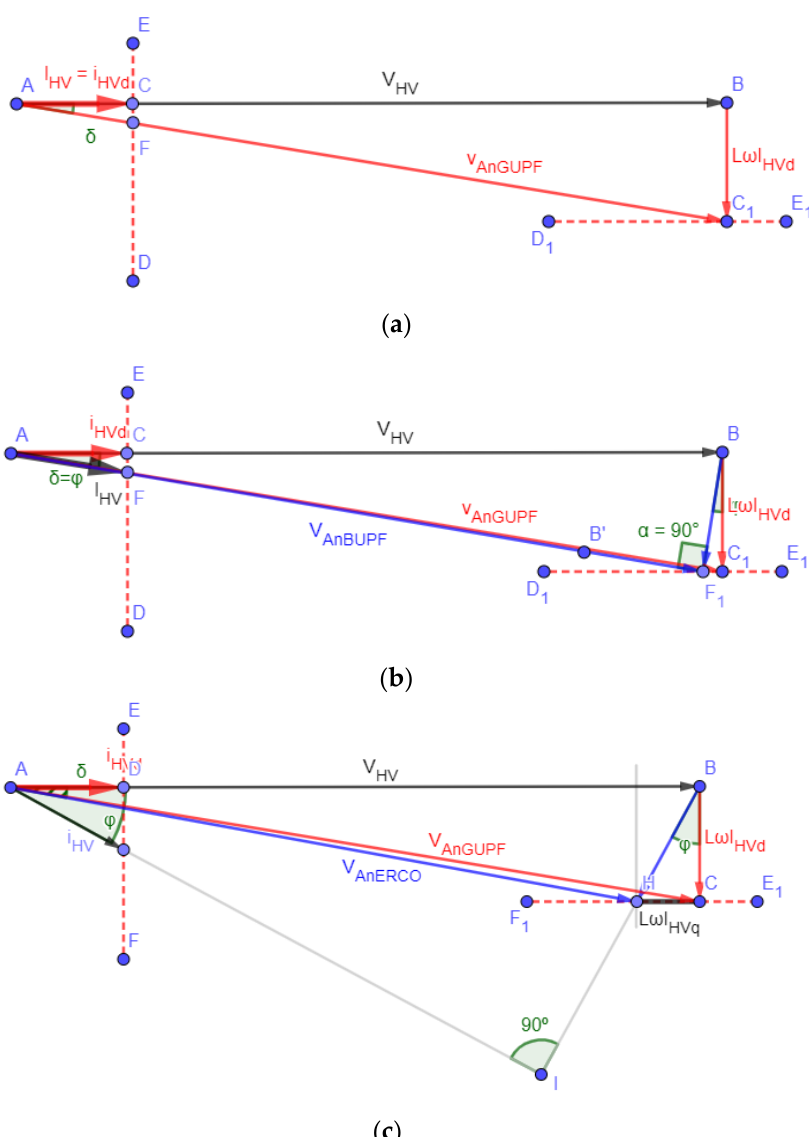
Figure 6. Vectorial representation of possible operation modes for the input side of the MPST: ( a ) grid UPF operation, ( b ) PEB UPF operation, ( c ) extended operation using reactive power (ERPO).